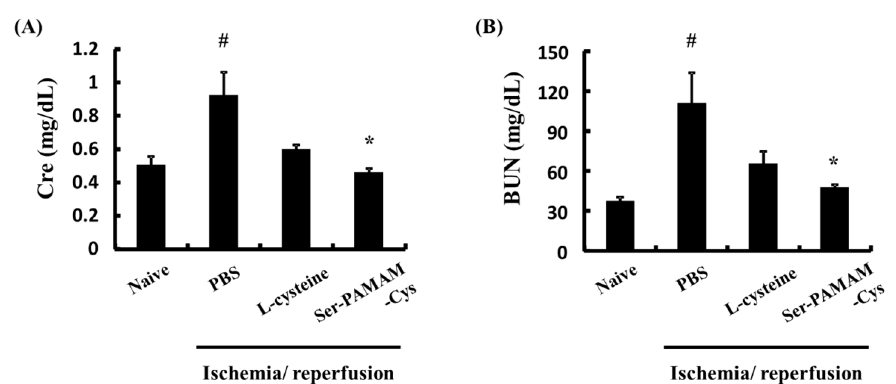
Figure 3. Effect of L-cysteine and Ser-PAMAM-Cys on plasma levels of ( A ) Cre and ( B ) BUN 24 h after ischemia/reperfusion. Results are expressed as means ± SE for five mice. # p < 0.05, significantly different from the naive group. * p < 0.05, significantly different from the ischemia/reperfusion + PBS group.